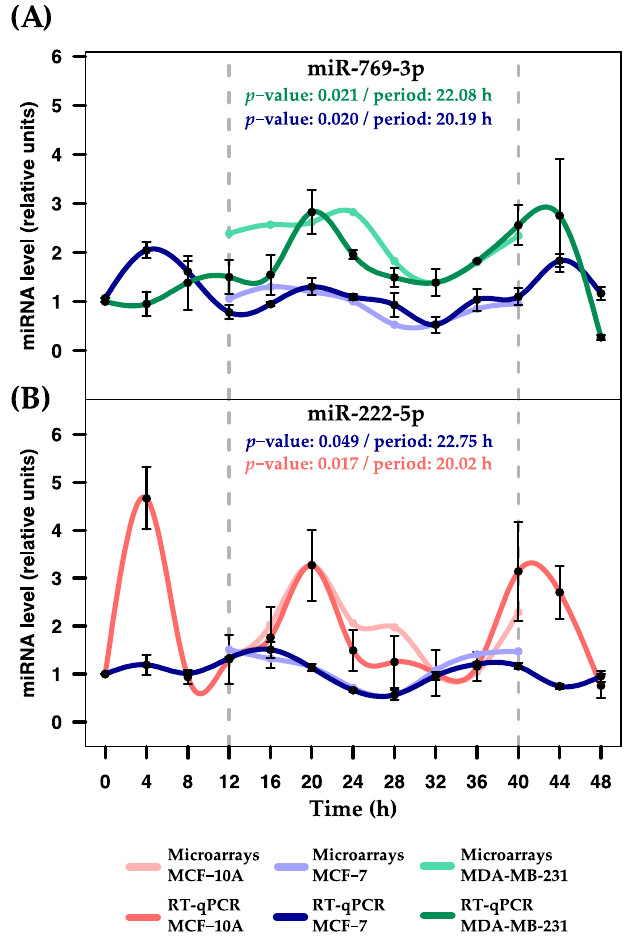
Figure 4. Expression profiles of miR-769-3p and miR-222-5p in three breast cell lines. Rhythmic expression was evaluated using RT-qPCR in serum-shocked MCF-10A, MCF-7, and MDA-MB-231 cells over 48 h (4 h intervals). ( A ) Rhythmic profiles of miR-769-3p obtained from microarray and RT-qPCR assays in MCF-7 and MDA-MB-231 cells; ( B ) Rhythmic profiles of miR-222-5p obtained from microarray and RT-qPCR assays in MCF-10A and MCF-7 cells. Data points (means of three biological replicates ± SEM) were normalized using miR-106a-5p relative to the first time point ( t = 0). The p -values and period values of rhythmic profiles were obtained from MetaCycle analysis and are illustrated at the top of each plot. Expression profiles with p -values less than 0.05 were considered rhythmic. For comparison purposes, the more lightly colored lines illustrate the expression profiles obtained from microarray assays, which were scaled to the expression profiles obtained from RT-qPCR assays. Dashed gray lines at 12 and 40 h were added to show the periods in which the profiles were measured by microarrays.